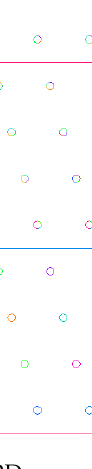
Figure 12. The 2D arrangement of holes.